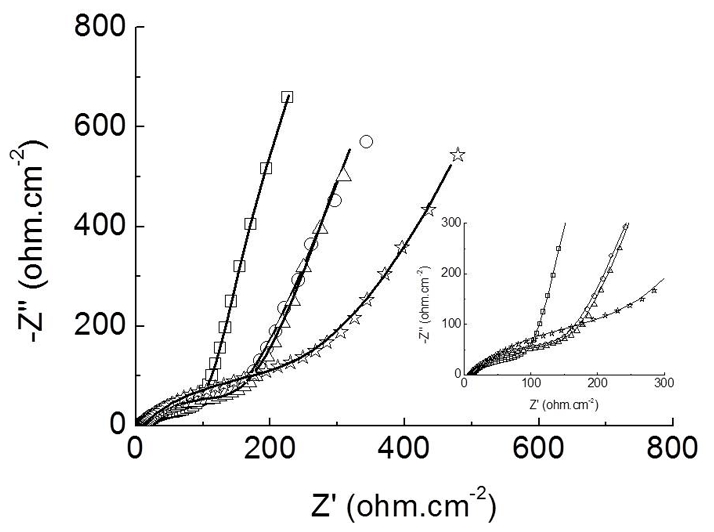
Impedance response of graphite electrode.Nyquist diagrams of a the polymeric film poly(3-HPA) (-□-), poly(3-HPA)/Am1 (-Δ-), poly(3-HPA)/Am1:IgG+ (-⋆-), and poly(3-HPA)/Am1:IgG- (-○-) obtained in aqueous solution containing K3Fe(CN)6/K4Fe(CN)6 (5 mmol.L−1) and KCl (0.1 mol.L−1), recorded from an applied potential of +0.24 V, amplitude of 10 mV, and frequency range from 100 KHz to 10 Hz. The continuous lines represent the fitting curve to the equivalent circuit. Inset: amplification of high frequencies region.